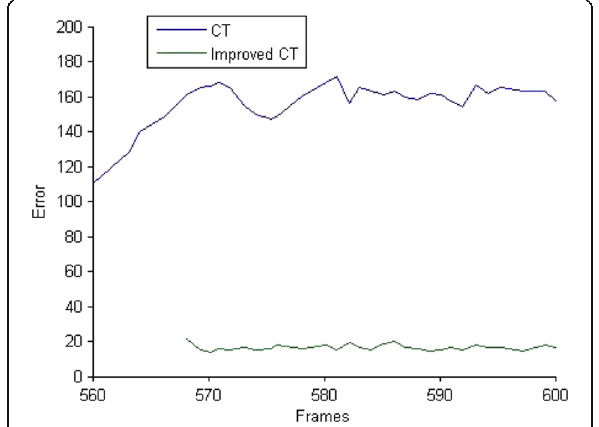
Fig. 15 The tracking error of the partial car